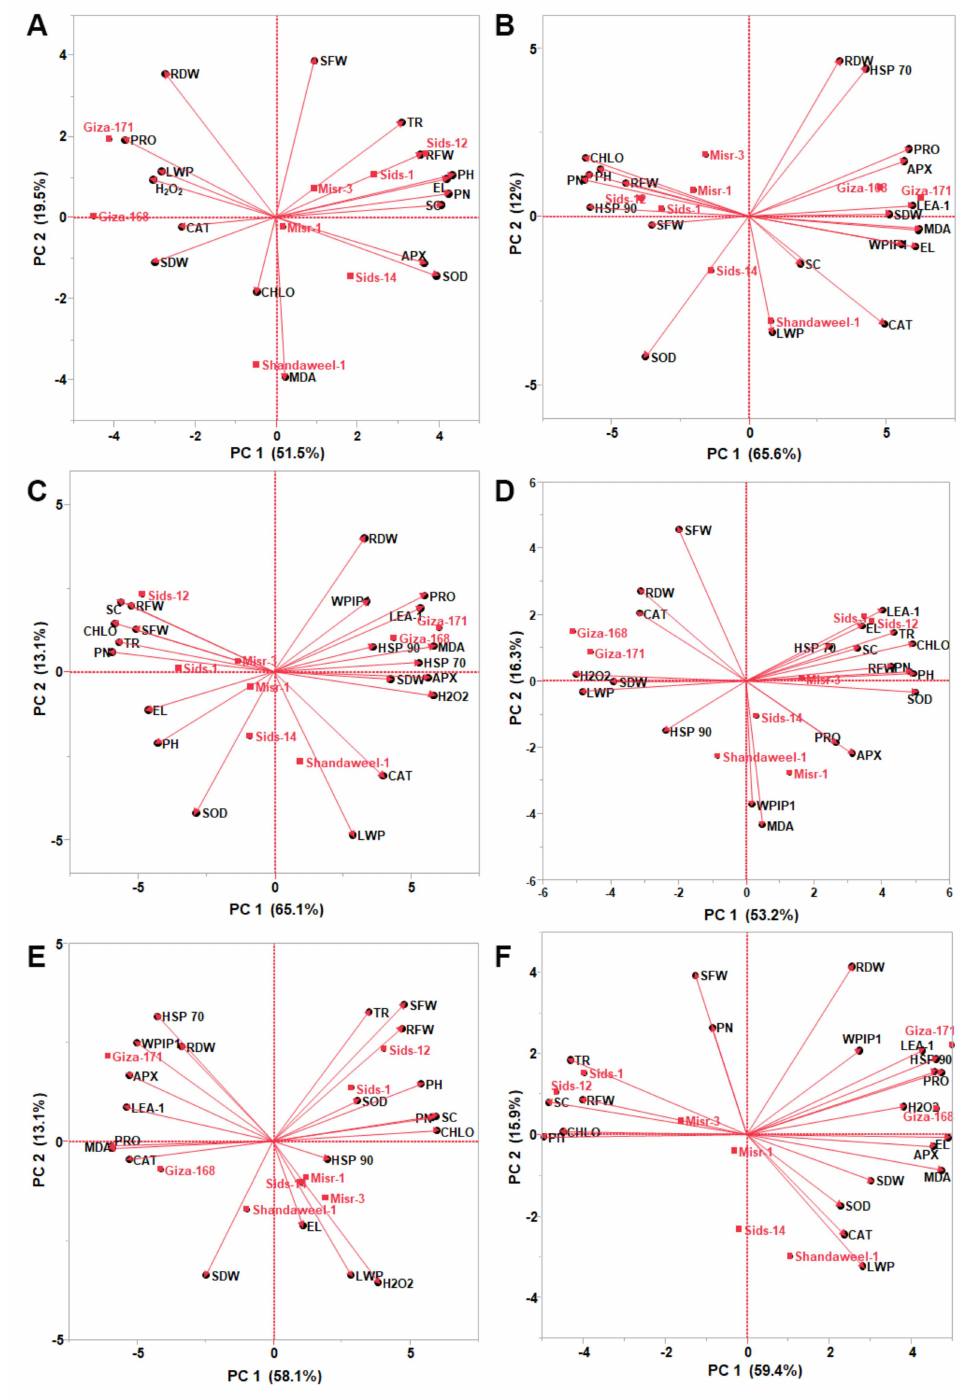
Figure 6. Distribution of eight wheat genotypes on biplot and the score plot PC1 and PC2 under different conditions: ( A ) Control (regular irrigation, 100% FC) (T1), ( B ) Drought (60% FC) (T2), ( C ) Heat (38 ◦ C) (T3), ( D ) 10 mg · L − 1 of SeNPs (T4), ( E ) Drought + 10 mg · L − 1 of SeNPs (T5), and ( F ) Heat + 10 mg · L − 1 of SeNPs (T6). Abbreviations: Plant Height (PH), Shoot Fresh Weight (SFW), Shoot Dry Weight (SDW), Root Fresh Weight (RFW), Root Dry Weight (RDW), Total Chloro- phyll (CHLO), Net Photosynthetic rate (PN), Stomatal Conductance (SC), Transpiration Rate (TR), Electrolyte Leakage (EL), Leaf Water Potential (LWP), Malondialdehyde (MDA), Hydrogen Per- oxide (H 2 O 2 ), Proline (PRO), Superoxide Dismutase (SOD), Ascorbate Peroxidase (APX), and Catalase